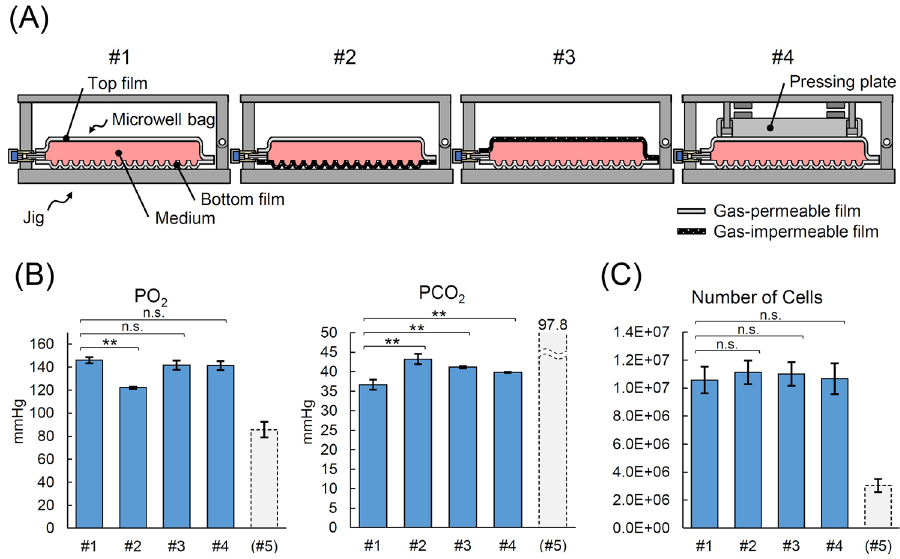
Figure 2. Effective gas exchange with gas-permeable films in closed culture. ( A ) A schematic illustration of the study. The top or bottom gas-permeable film of a microwell bag was replaced with a gas-impermeable film. #1: control gas-permeable bag, #2: bottom film was replaced with gas-impermeable film, #3: top film was replaced with gas-impermeable film, and #4: the top of a bag was covered with a plastic plate, which may inhibit gas exchange, to keep the medium height constant. The human induced pluripotent stem cells (hiPSCs) were cultured for 2 days using φ 0.50 mm bags. ( B ) Oxygen- and carbon dioxide partial pressure (PO 2 and PCO 2 , respectively) in the medium at the end of culture measured using the offline method. ( C ) The number of harvested cells in each bag. Data represent mean ± standard deviation ( n = 3); * P < 0.05, ** P < 0.01, n.s., not significant; #5: the values when both the top and bottom films were replaced with gas-impermeable